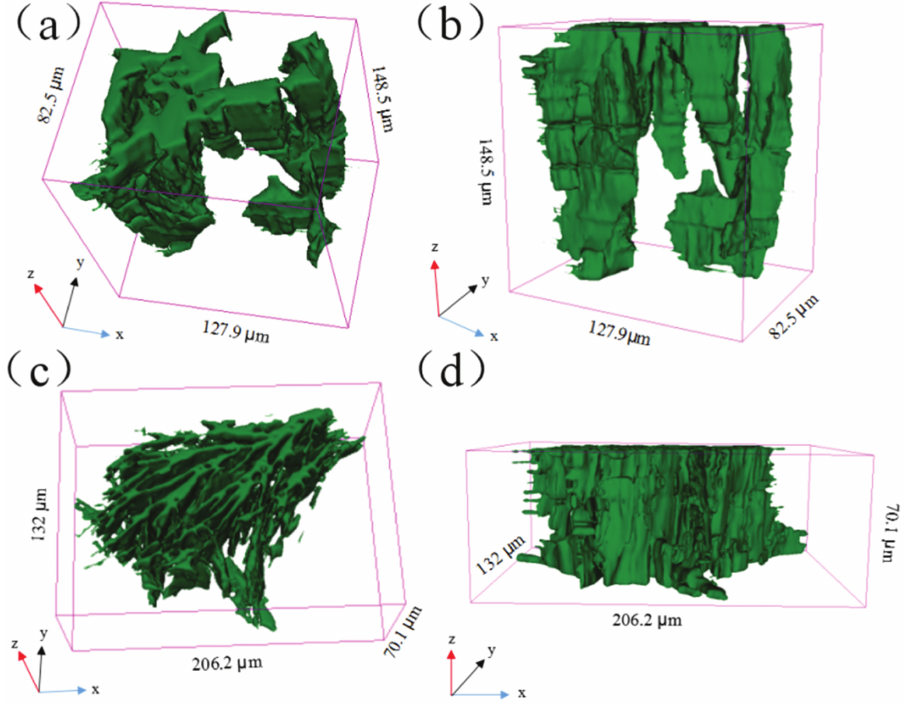
Figure 6: 3D microstructure of calcium ferrite in vanadium-titanium sinter (a), (b) and in traditional sinter (c),